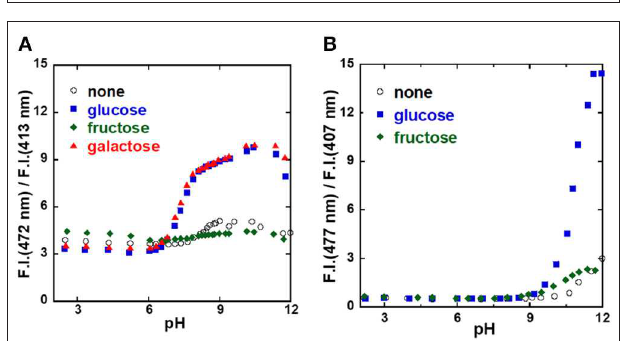
FIGURE 5 | pH profiles of probe [ (A) 1 , (B) 2 ]/ γ -CyD complexes in 2% DMSO − 98% water (v/v). [probe] = 10 µ M, [ γ -CyD] = 5mM, [sugar] = 0 or 30mM, [phosphate buffer] = 10mM, [NaCl] = 100mM, λ ex =